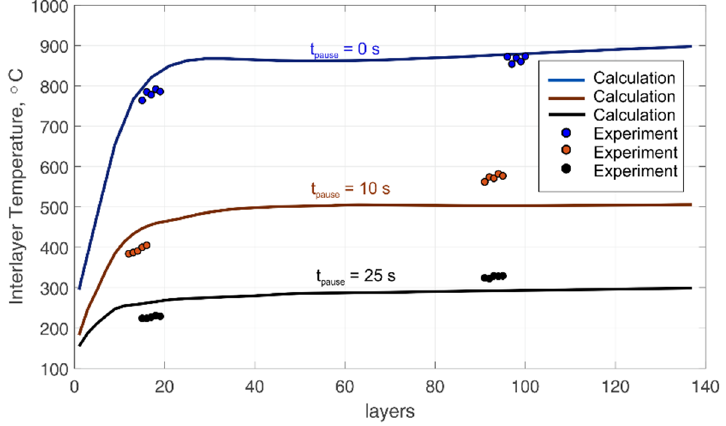
Figure 10. Change in interlayer temperature depending on the pause time between passes.